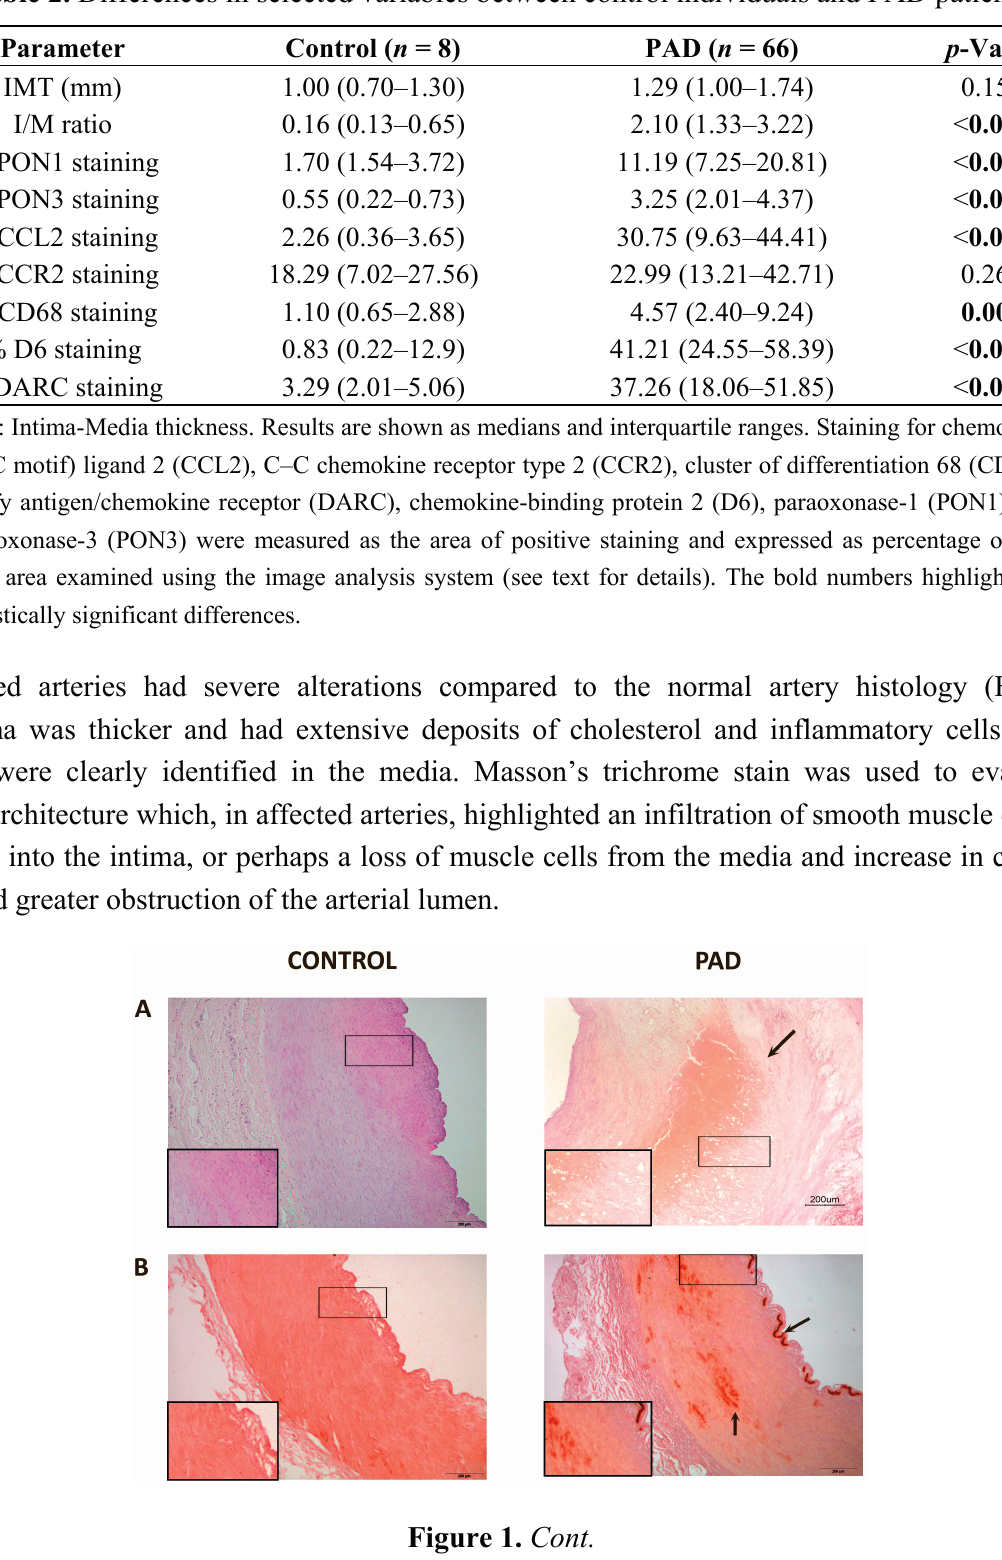
Table 2. Differences in selected variables between control individuals and PAD